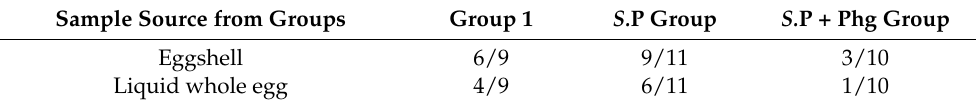
Table 1. Number of S. Pullorum-positive samples on the total of collected laid eggs. Sample Source from Groups